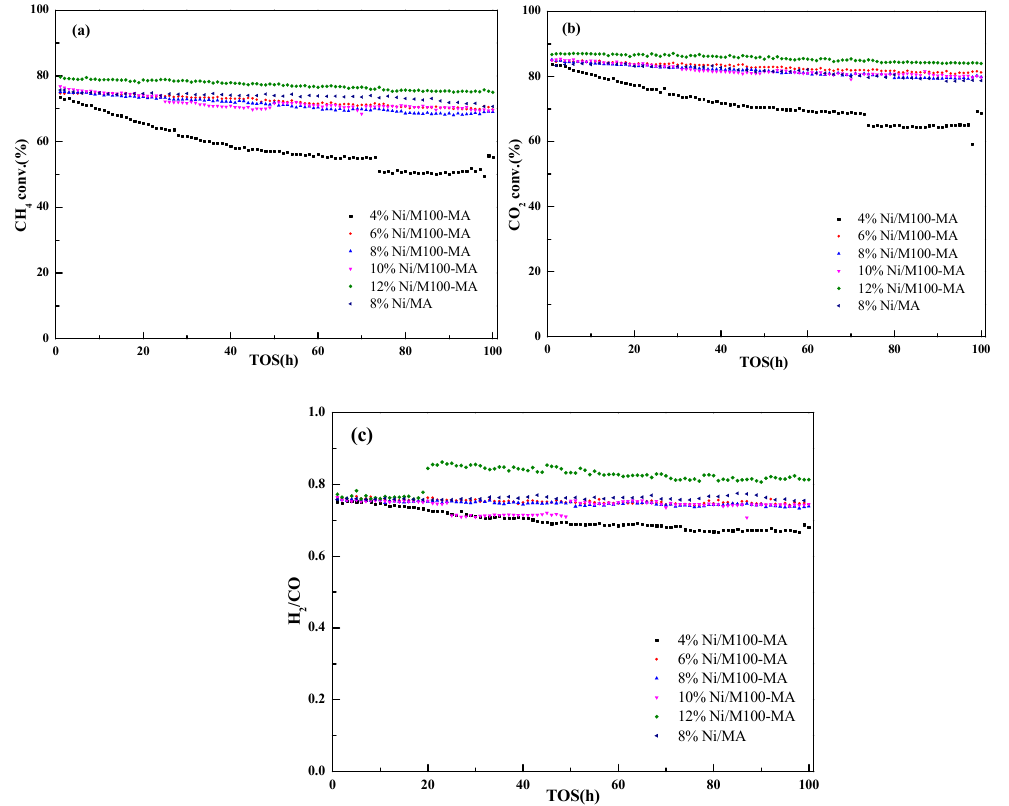
Figure 7. Evaluation of CH 4 conversion ( a ), CO 2 conversion ( b ), and H 2 / CO ( c ) over catalysts during the dry reforming of methane (DRM) reaction. Reaction conditions: CH 4 / CO 2 / Ar = 45 / 45 / 10, W / F = 1 g · h / mol, T = 700 ◦ C, TOS = 100 h.